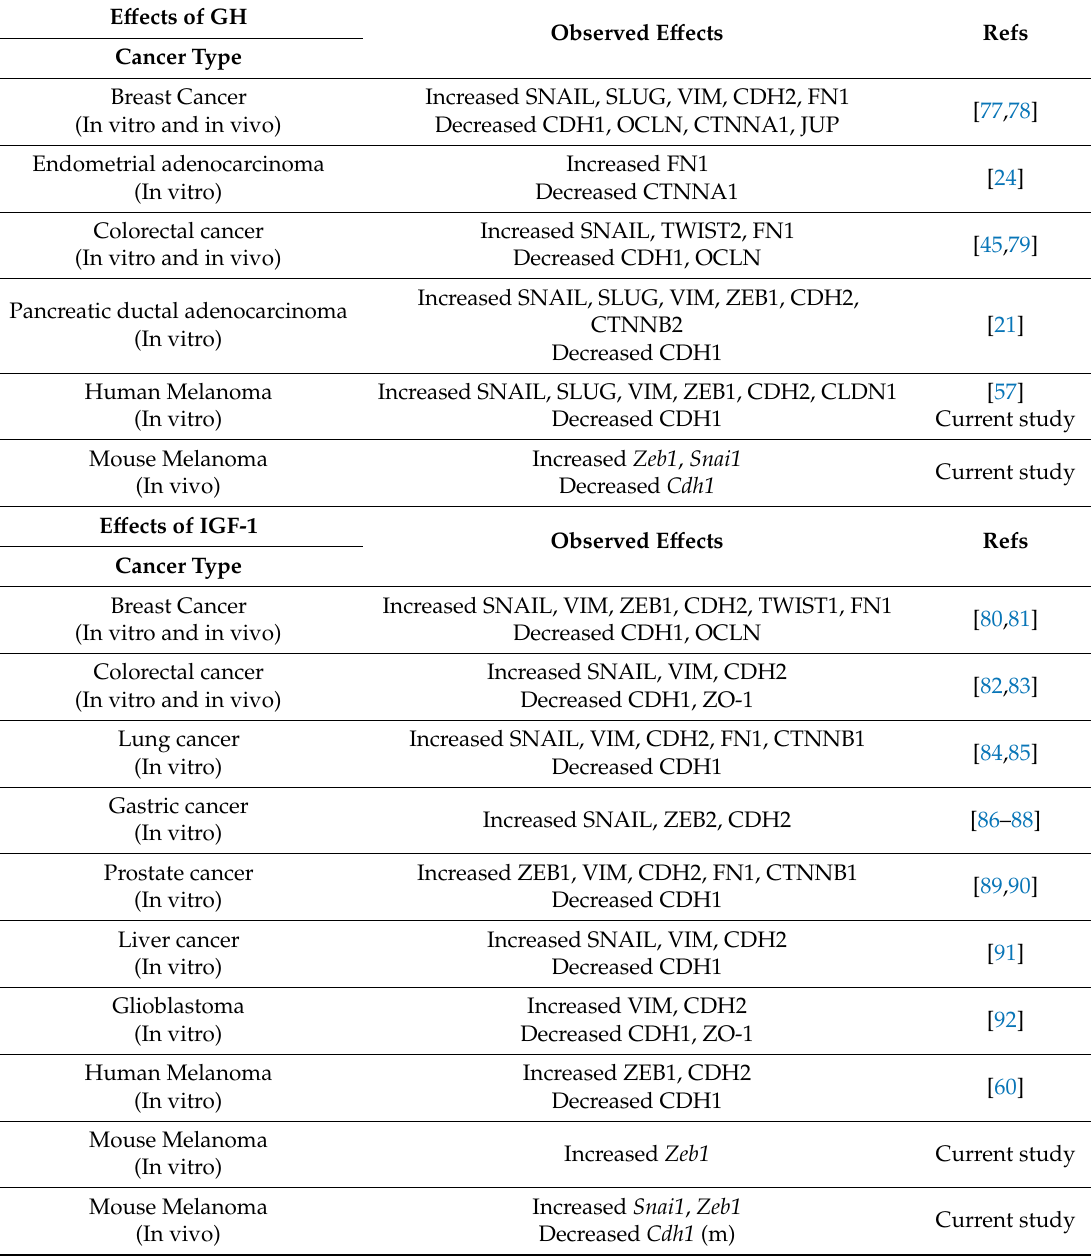
Table 2. Summary of the e ff ects of GH and IGF-1 on EMT mediators in di ff erent cancers. E ff ects of